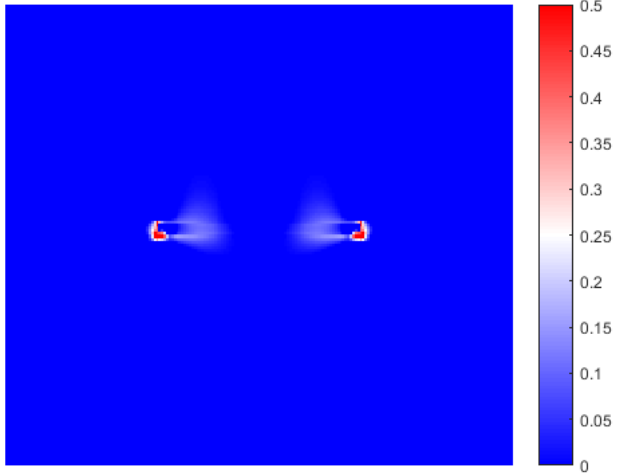
Figure 6. Electric field enhancement for extinction peak of 0.1 μm high n-Ge particle. The scale is logarithmic and the electric field enhancement is normalized to the incident electric field.